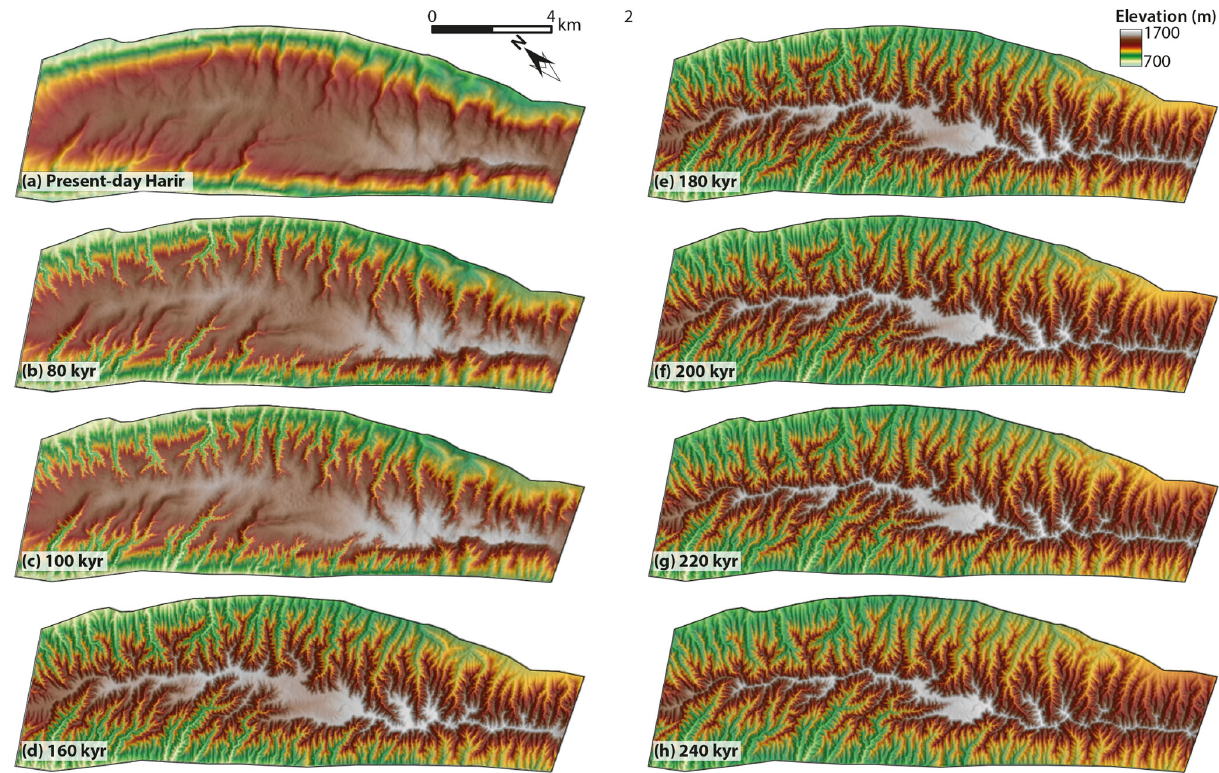
Figure 8. The input landscape (a) , which is the present-day Harir topography, and the evolved landscape through time; (b) 80, (c) 100,